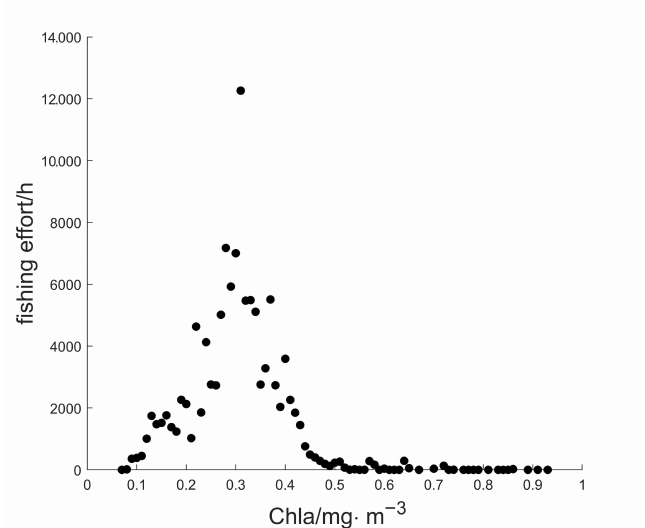
Figure 9. The overlay map of Chla (color shading; units: mg · m − 3 ) and monthly fishing efforts (circle; units: h) of O. bartramii in the North Pacific Ocean from July to November between 2017 and 2020.